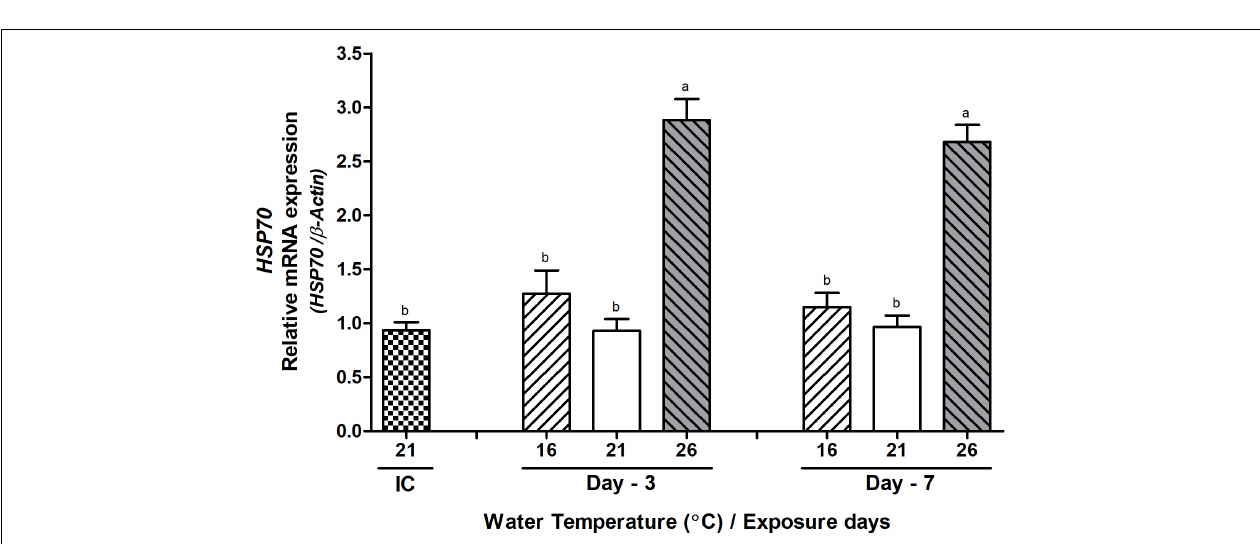
FIGURE 10 | Changes in the relative mRNA expression of HSP70 in the testis of Pacific abalone during the peak breeding season after exposure to thermal stress for 7 days. Before exposure to the target temperature of thermal stress, abalone were sampled to obtain reference values that served as initial control (IC). Values represent the mean ± SD ( n = 10). Different letters on the bar indicate significant differences among different temperature groups ( p <